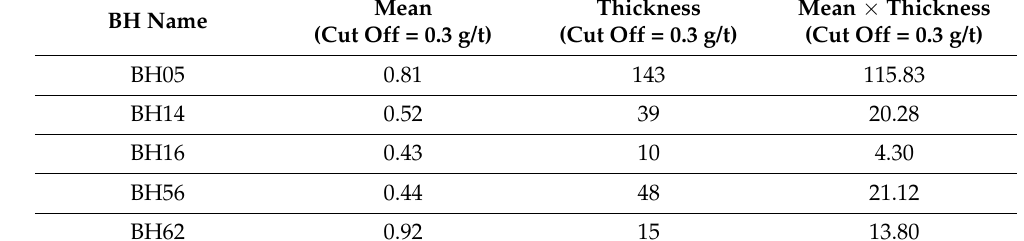
Table 1. Borehole productivity.